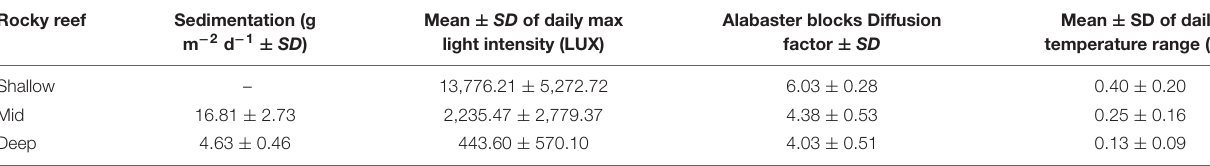
TABLE 1 | Summary of physical variables measured at rocky reefs with different